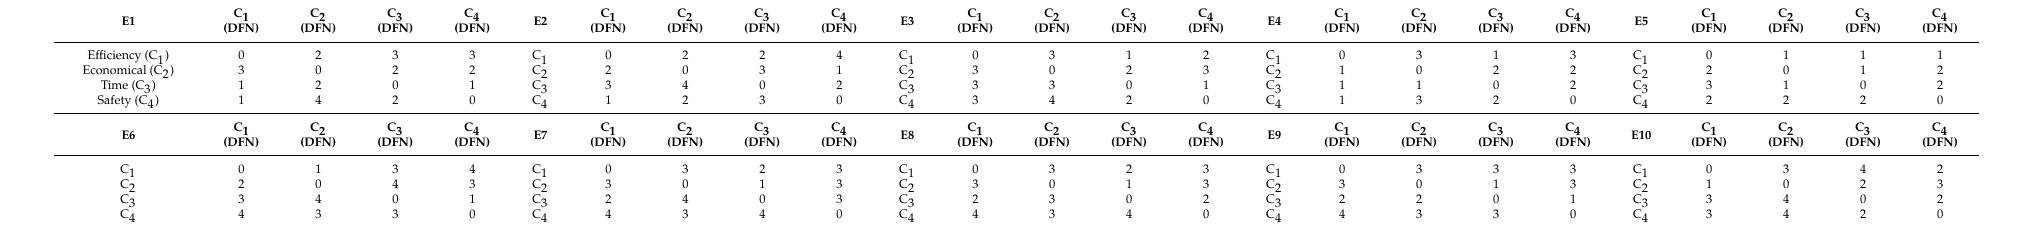
Table A1. Degree of direct fuzzy influence between criterions.